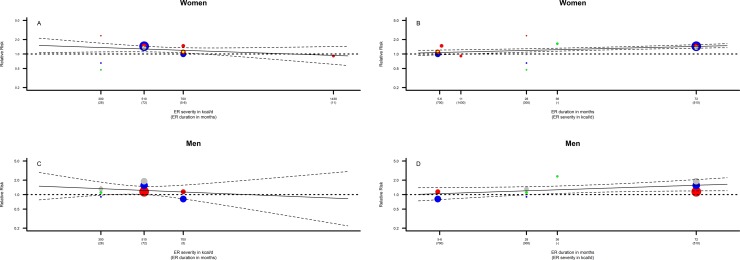
An overview of some of the contextual aspects of energy restriction that might modulate the association of early-life energy restriction with cancer risk.Note: The estimated caloric intake (in units of 100 kcal/day) was based on the mid-point caloric intake reported in the publications and was plotted against the reported relative risk ratios from the individual studies separately for women (panel A) and men (panel C). The estimated duration of ER (in months) was plotted against the reported relative risk ratios from the individual studies separately for women (panel B) and men (panel D). In women, the data points indicated in red represent studies reporting on breast cancer risk or mortality; the data points indicated in blue represent studies reporting on colorectal cancer risk or mortality; the data points indicated in green represent studies reporting on stomach cancer risk or mortality; the data points indicated in grey represent studies reporting on lung cancer risk or mortality; and the data points indicated in yellow represent a report on ovarian cancer risk. In men, the data points indicated in red represent studies reporting on prostate cancer risk or mortality; the data points indicated in blue represent studies reporting on colorectal cancer risk or mortality; the data points indicated in green represent studies reporting on stomach cancer risk or mortality; and the data points indicated in grey represent studies reporting on lung cancer risk or mortality. The dashed lines indicate the confidence intervals of the meta-regression line.